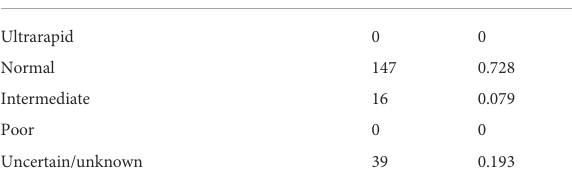
TABLE 3 Inferred metaboliser frequencies within